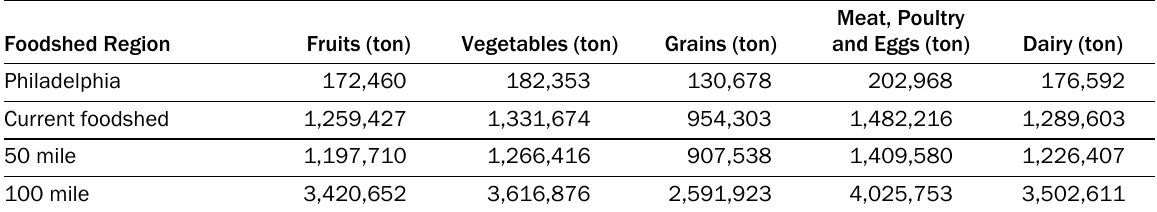
Table 6. Food Consumption in Philadelphia and Three Foodshed Regions According to ERS Food Availability Data